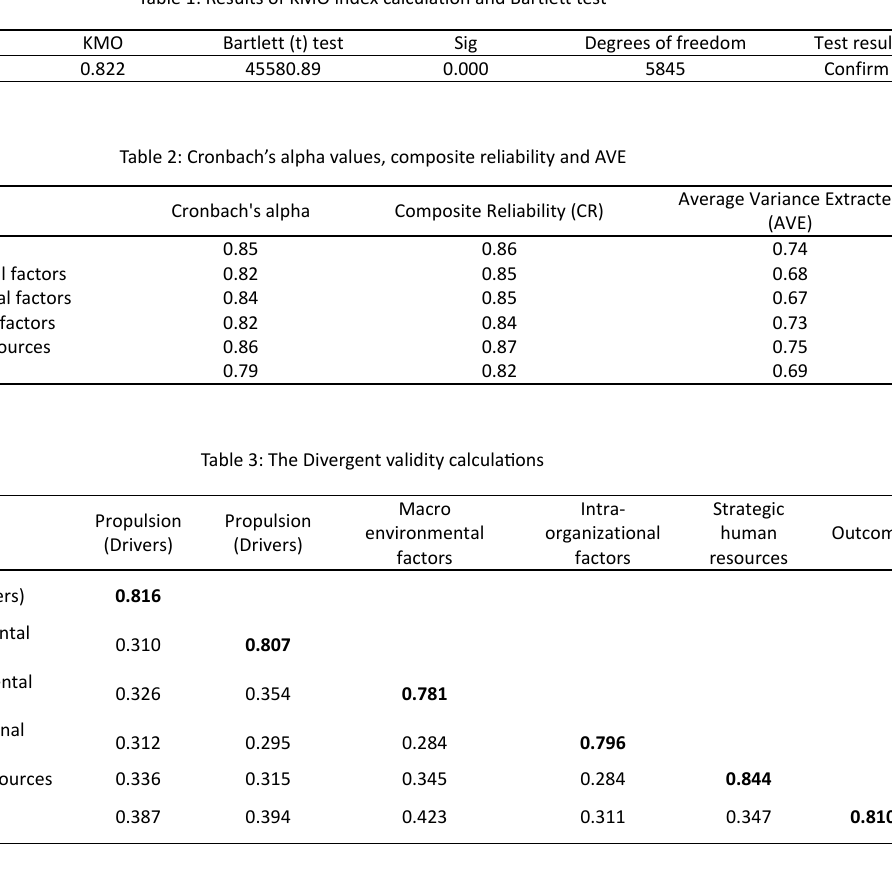
Table 1: Results of KMO index calculation and Bartlett test